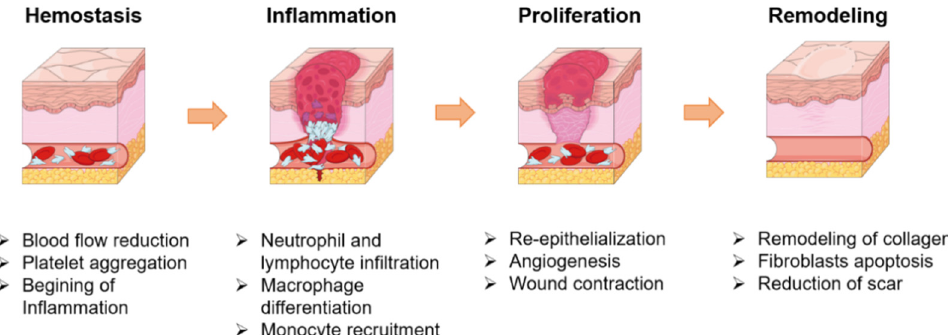
Figure 2. Wound healing is a complex process that can be divided into different phases: hemostasis, inflammation, proliferation and tissue remodeling. Promptly after injury, hemostasis and inflammation occur, which is characterized by the influx of inflammatory cells. Consequently, the proliferative phase is marked by collagen deposition, angiogenesis, granulation tissue formation and epithelization. At the very least, the tissue remodeling phase is characterized by declined cellularity and matrix remodeling. Moreover, it is during this phase that the wound undergoes contraction which can result in the formation of a scar. Based on [20] and adapted and modified from Servier Medical Art. Servier is licensed under a Creative Commons Attribution 3.0 Unported License.